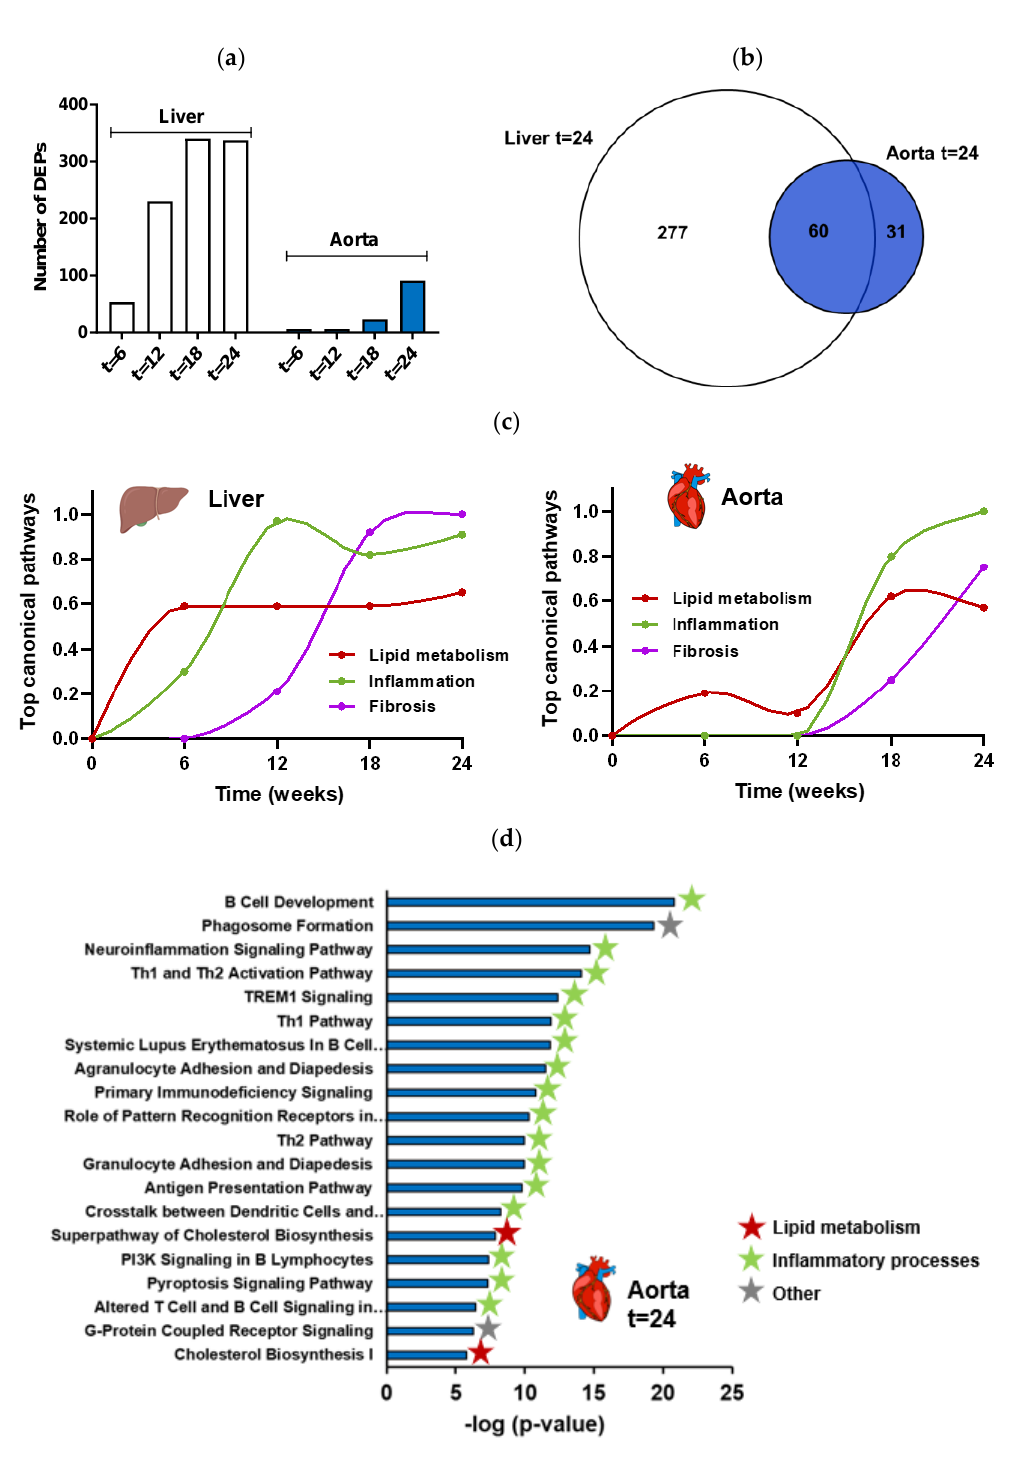
Figure 2. Number of differentially expressed pathways (DEPs) in liver and aorta (of the same mice) between Ldlr−/−.Leiden mice fed a high-fat diet (HFD) for 6, 12, 18 or 24 weeks ( n = 15 per time point) vs. mice fed a healthy chow diet ( n = 6 per time point) ( a ). Venn diagram showing the overlap of DEPs in liver and aorta in Ldlr−/−.Leiden mice after 24 weeks on HFD vs. chow diet ( b ). Graphic visualization of the temporal dynamics of key processes involved in the development of NASH (left panel) and atherosclerosis (right panel) in Ldlr−/−.Leiden mice as determined by time-resolved analysis of the top canonical pathways ( c ). The top 20 of significantly enriched biological processes ( − log( p -value)) in aorta in Ldlr−/−.Leiden mice after 24 weeks on HFD vs. chow diet ( d ).